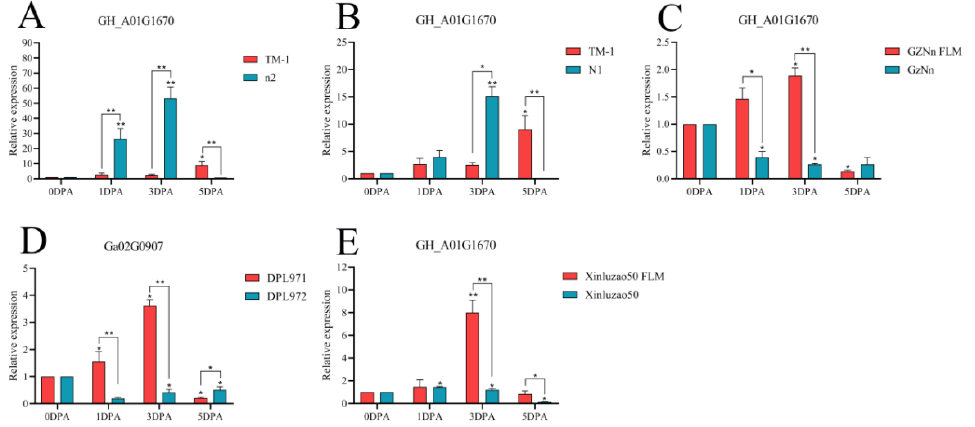
Figure 14. Relative expression levels of the GH_A01G1670 gene in upland cotton. ( A – C , E ) Upland cotton; ( D ) homologous gene of Asian cotton. Asterisks at top of bars indicate statistically significant differences between periods (* p < 0.05, ** p < 0.01).